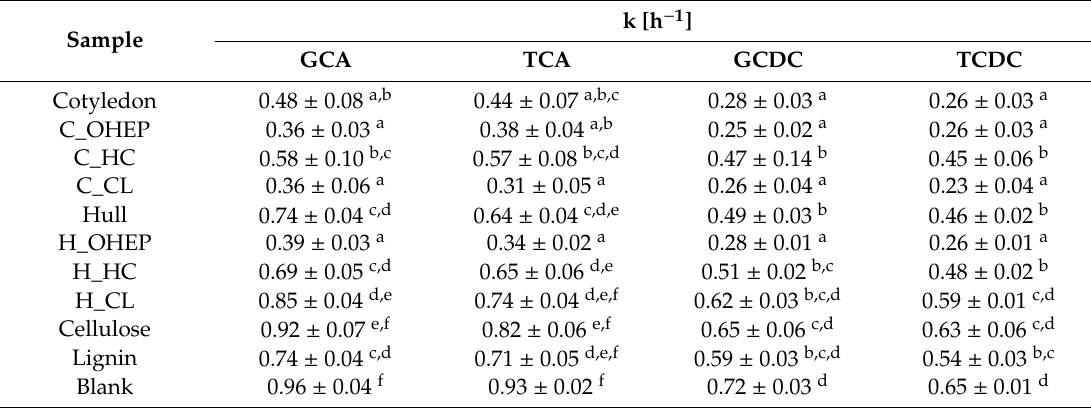
Table 3. Apparent permeability rate constants (k) of kinetic bile acids release analysis (glycocholic acid (GCA), taurocholic acid (TCA), glycochenodesoxycholic acid (GCDC), and taurochenodesoxycholic acid (TCDC)) of in vitro digesta containing fractionated dietary fibre (pectin-like fraction (OHEP), hemicellulose fraction (HC), cellulose-lignin fraction (CL)) derived from lupin cotyledon and hull of L. angustifolius L. Boregine, cellulose and lignin ( n = 3). k [h − 1 Sample